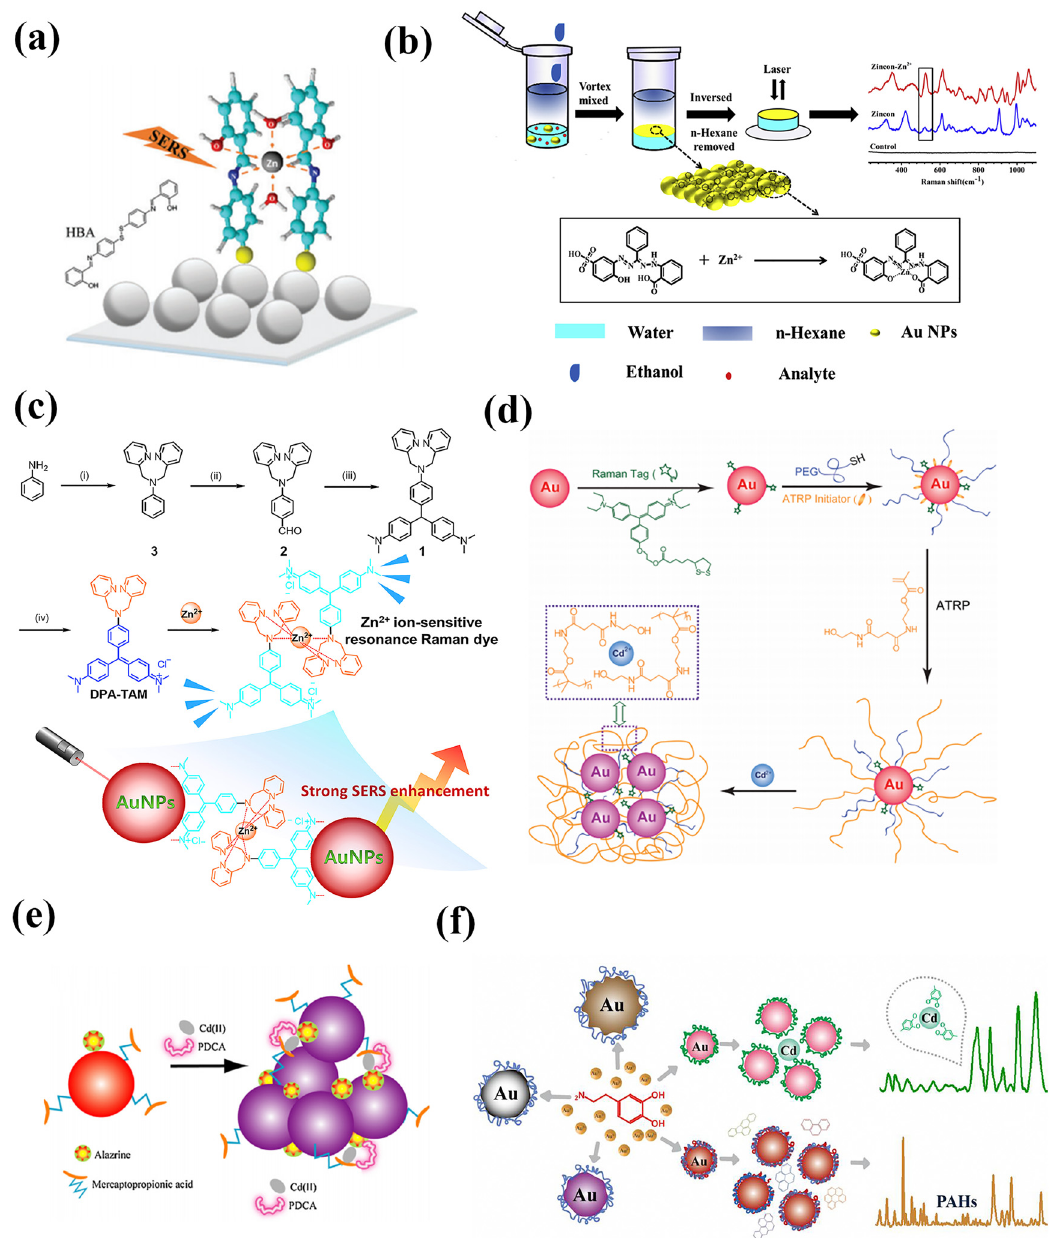
Figure 6: Different SERS sensors for detection of Zn 2 + and Cd 2 + ions. (a) Zn 2 + ions coordinated with HBA on Ag nano fi lm [111]. (b) Zn 2 + ions bond to the Zincon on the surface of the liquid – liquid self-assembled AuNAs [115]. (c) DPA-TAM-AuNP self-assembly system to detect Zn 2 + ions [114]. (d) Cd 2 + ions combined with HEBAMA [116]. (e) Initial alizarin adsorption,andsubsequentMPA-PDCAconjugationonthesurfaceofAuNPs[117].(f)SimultaneousdetectionofCd 2 + ionsandPAHsaccording to the oxidation of dopamine through a classic Raper – Mason reaction mechanism